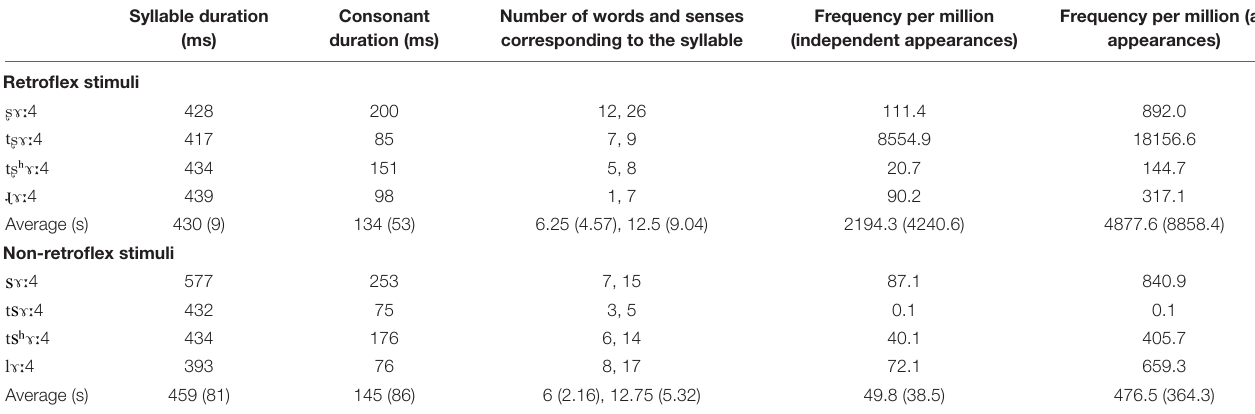
TABLE 1 | Acoustic properties and lexical information of the stimuli.